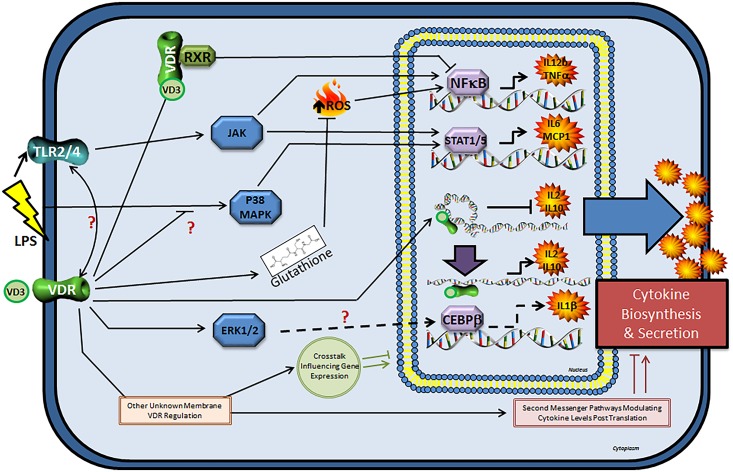
Overview of VDR-mediated regulation of cytokine transcription, production and secretion in immune cells.Interaction of VD3 and VDR leads to anti-inflammatory effects through negative regulation of NFκB and STAT1/5-mediated signalling. This results in decreased transcription of TNF-α, IL-6, MCP1 and IL-12β. VDR activation promotes increased intracellular glutathione levels that partially or fully attenuates excessive ROS production (ROS can activate pro-inflammatory NFκB signalling). Activated VDR regulates transcription of IL-2 and IL-10 through epigenetic and conformational changes in the promoter region of these genes. VDR association with the promoter region occurs in a cyclic fashion, which leads to initial gene suppression, followed by upregulation of IL-2 and IL-10 expression after 48 hours. Pro-inflammatory effects of VD3 were reported and suggested to be linked to increased IL-1β production possibly related to increased ERK1/2 phosphorylation and the transcription factor CEBPβ. The VDR is believed to modulate pro-inflammatory TLR expression both positively and negatively, but the mechanisms are unknown. Plasma membrane associated VDR may induce rapid effects through non-genomic pathways such as modulation of intracellular calcium levels, parathyroid hormone G-protein coupled or other second messenger systems. Non-genomic pathways may cooperate with genomic pathways to influence gene expression. CCAAT/enhancer binding protein beta (CEBPβ), extracellular signal-regulated kinase1/2 (ERK1/2), janus kinase (JAK), monocyte chemotatic protein1 (MCP-1), nuclear factor kappa light chain enhancer of activated B cells (NFκB), mitogen activated protein kinase (p38 MAPK), retinoid X receptor (RXR), reactive oxygen species (ROS), signal transducer and activator of transcription1/5 (STAT1/5), toll-like receptor-2/4 (TLR2/4), tumour necrosis factor alpha (TNF-α), vitamin D3 (VD3), vitamin D receptor (VDR).